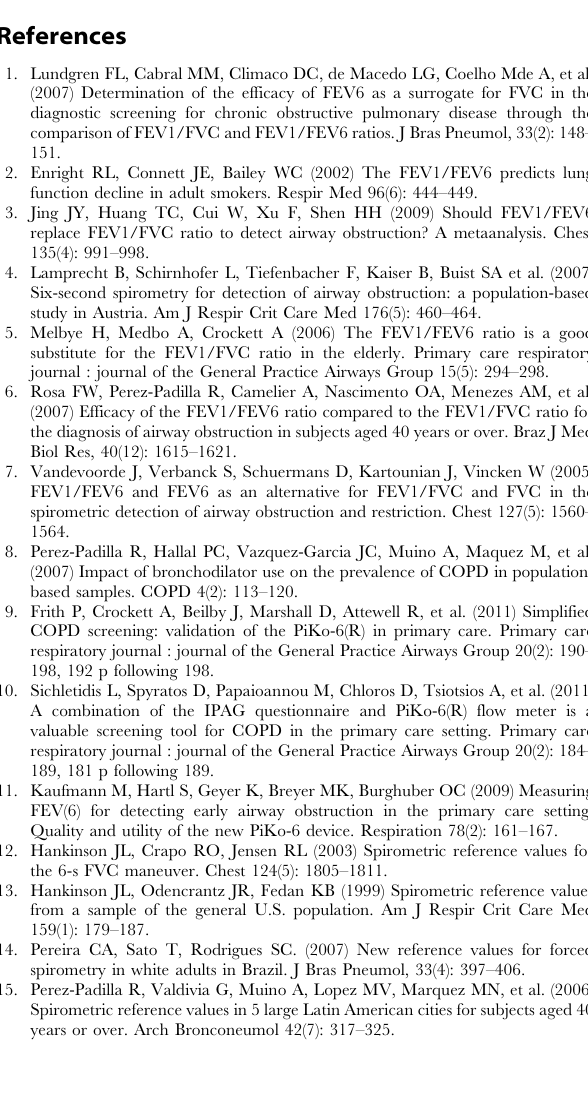
Table S5 False-positive and false-negative rates of self- reported COPD compared to two gold standards based on a post-Bronchodilator (post-BD) FEV 1 /FEV 6 , LLN. * Self-reported COPD is a physician’s diagnosis of COPD, emphysema or chronic bronchitis reported by the individual. %P is the spirometric value expressed as percentage of predicted